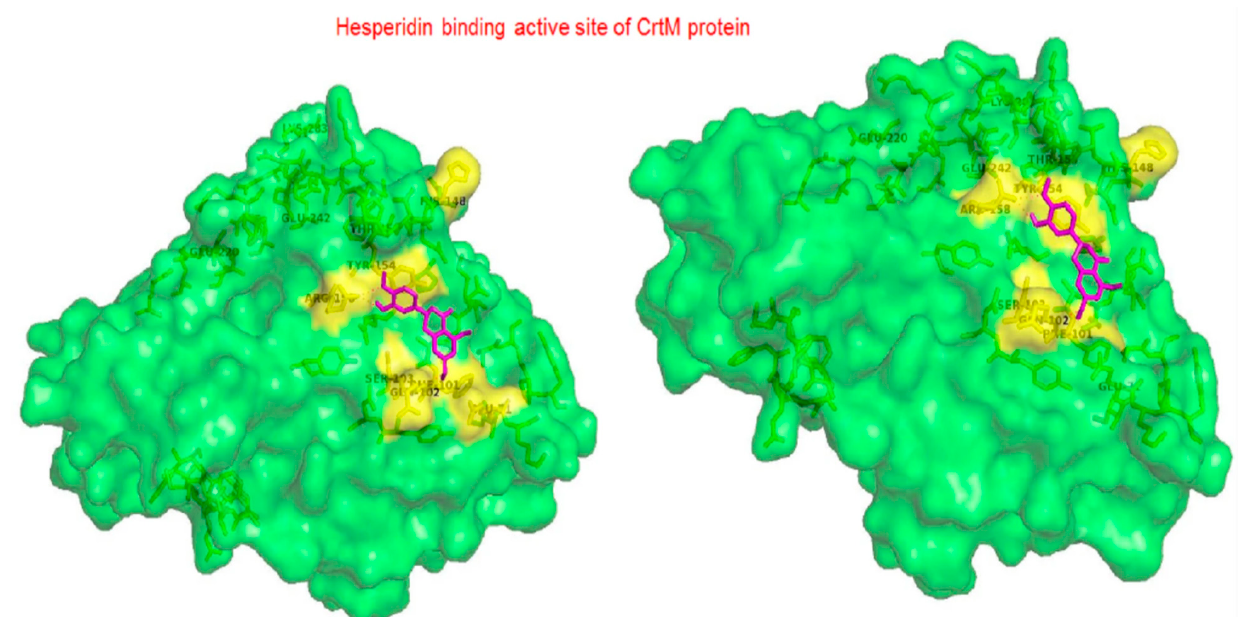
Figure 5. Molecular docking analysis showing 3D representation of interaction patterns of hesperidin with dehydrosqualene synthase receptor.